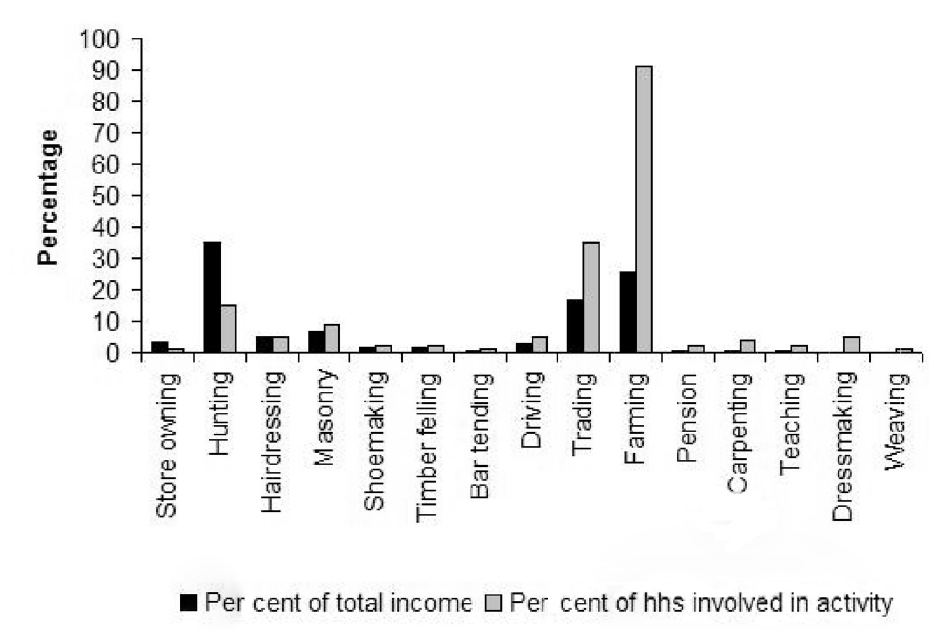
Proportion of total income derived from various economic activities in the study villages, and percentage of households involved in those